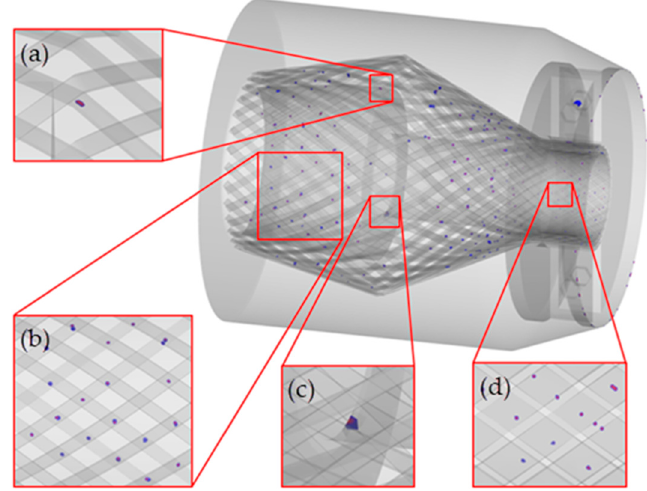
Figure 5. Air trap distribution results: ( a ) bending of the steel wires; ( b ) overlap of the steel wires; ( c ) corner of the cavity wall; and ( d ) gathering of the steel wires.